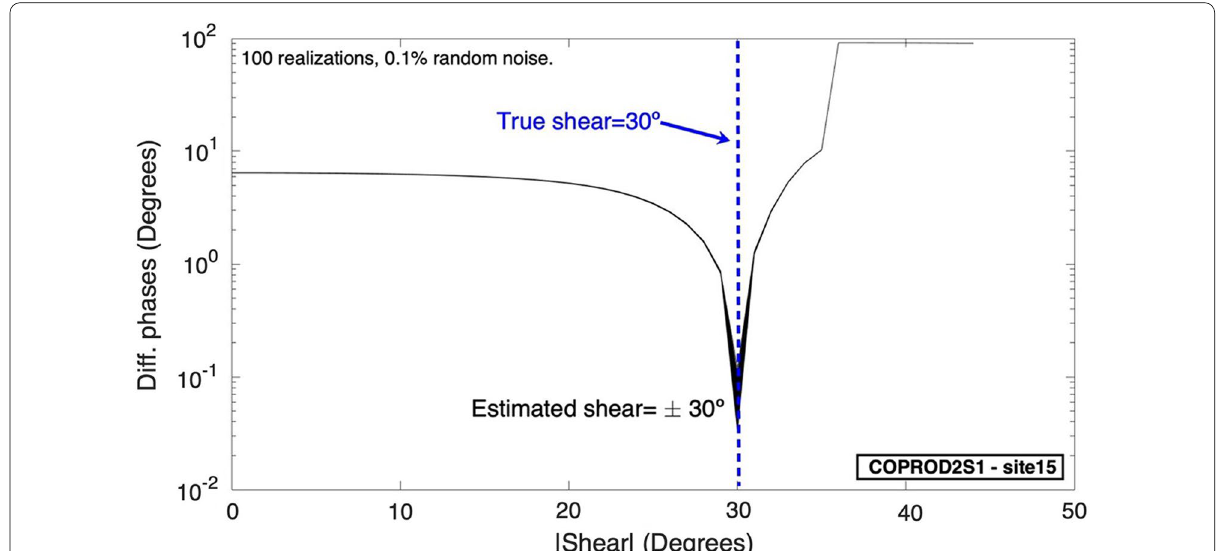
and ∅ from the quadratic equation with (cid:31) max and (cid:31) min from the + −